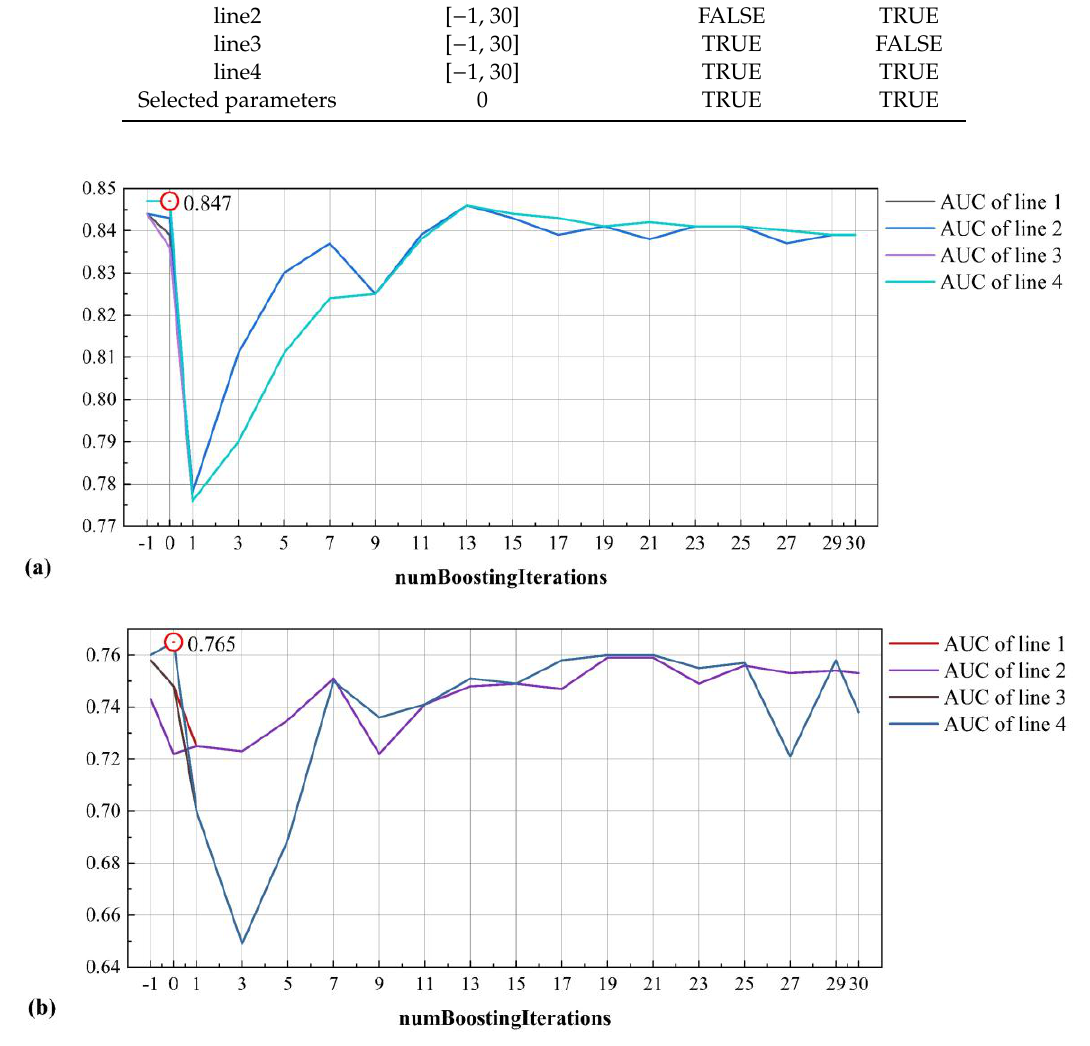
Figure 9. Optimization of parameters for the logistic model tree (LMT) model: ( a ) training dataset; ( b ) validation dataset. Table 2. Relevant parameters of the LMT model.